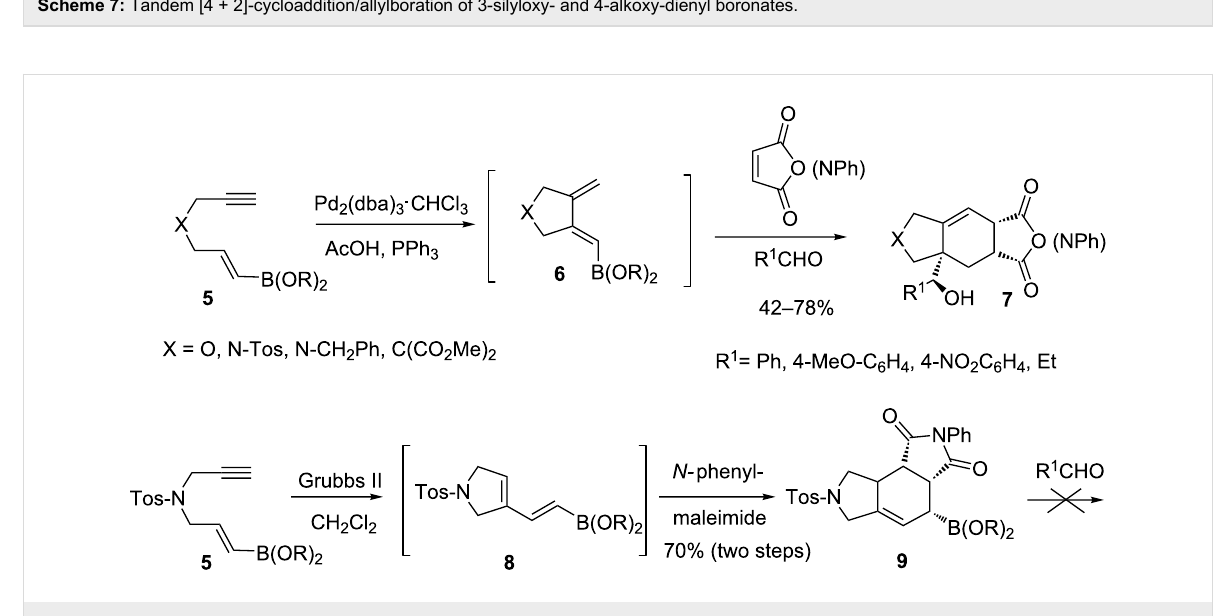
Scheme 8: Metal-mediated cycloisomerization/Diels–Alder reaction/allylboration